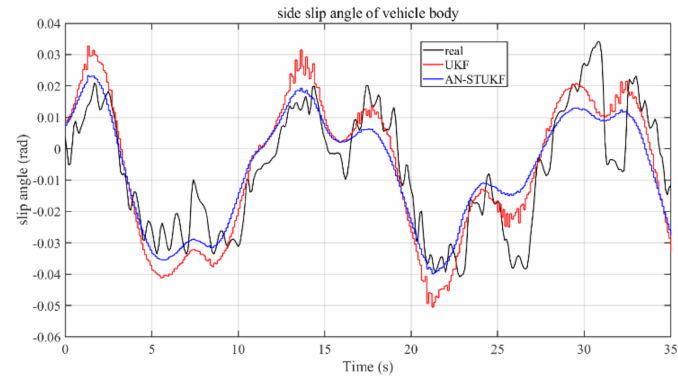
Figure 18. The sideslip angle of vehicle body.